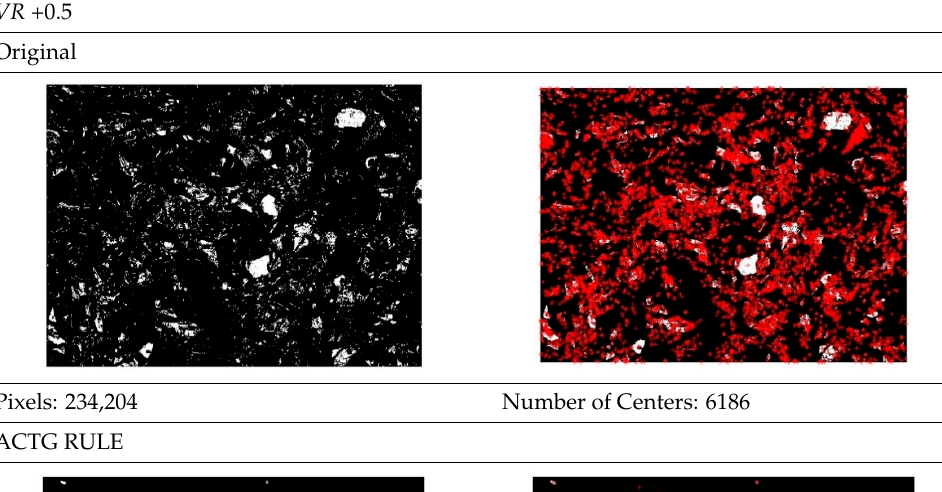
Table A2 . Images and associated pixels and number of centers corresponding to VR = +0.5.